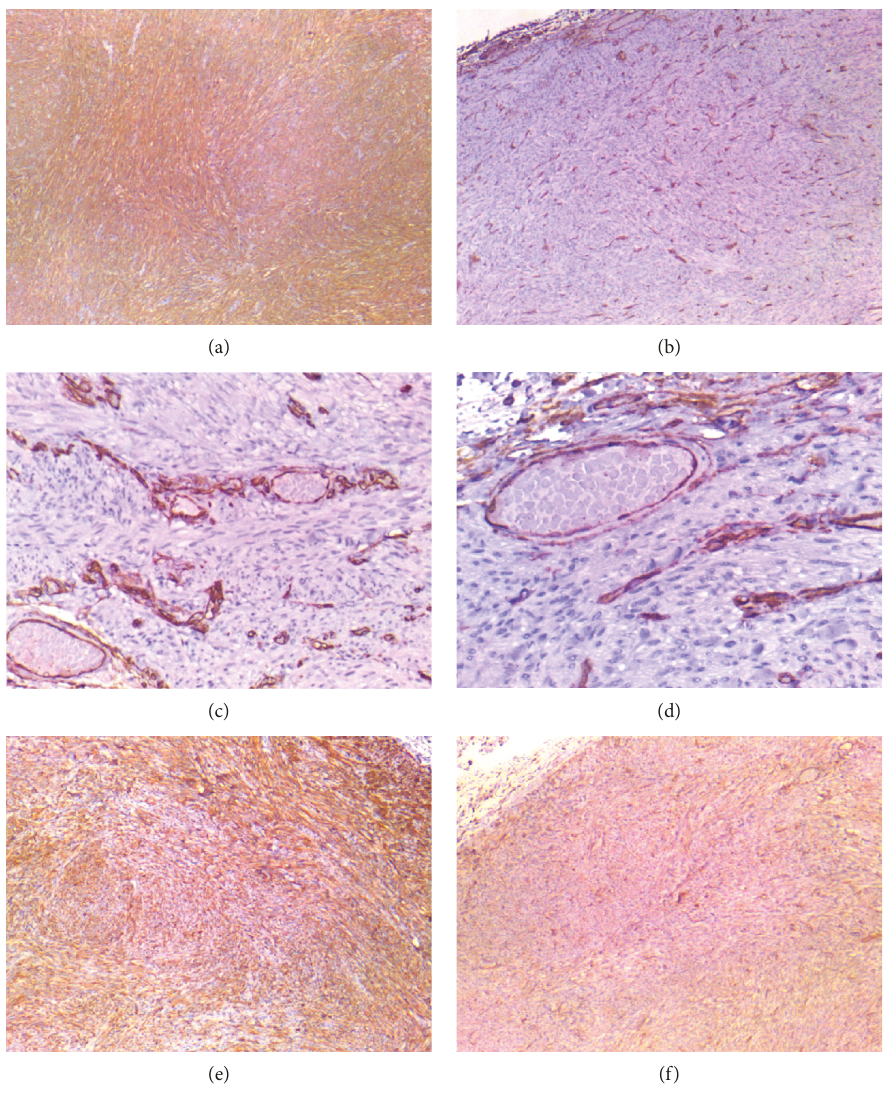
Figure 3: Immunohistochemical fi ndings of the case of angioleiomyoma reported. (a) The tumor cells show strong and di ff use SMA expression (4x); (b) blood vessels endothelium marked with CD34 immunostaining (4x); (c) blood vessels endothelium marked with CD34 immunostaining at high magni fi cation (10x); (d) blood vessels endothelium marked with CD34 immunostaining at high magni fi cation (20x); (e) the tumor cells show strong and di ff use desmin expression (4x); (f) uniformly staining for vimentin